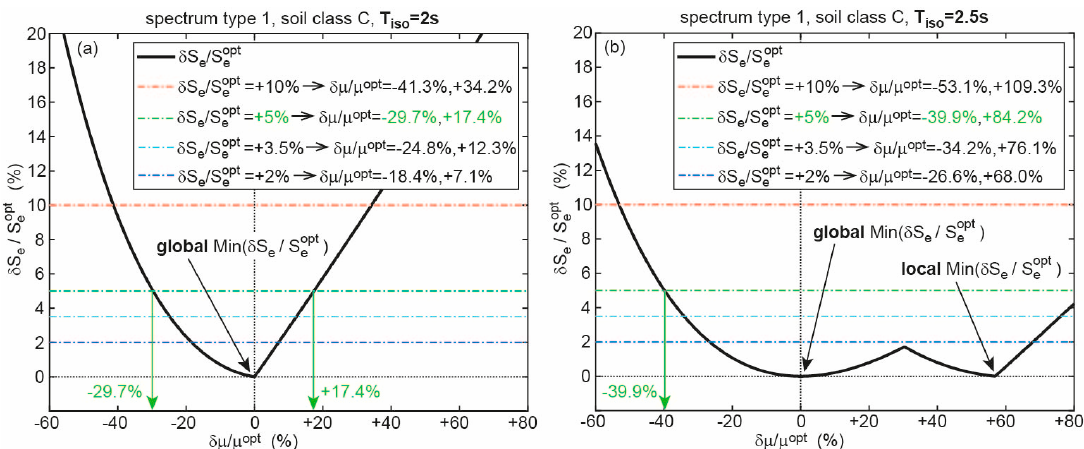
Figure 15. Sensitivity of deviation in friction coefficient from its optimum value on relative increase of structural acceleration for ( a ) T iso = 2 s and ( b ) T iso = 2.5 s and spectrum of type 1 with soil class C. δ S e / S opt e : deviation of structural acceleration relative to its optimum (minimum) value; δµ / µ opt : deviation of friction coefficient relative to its optimum value.